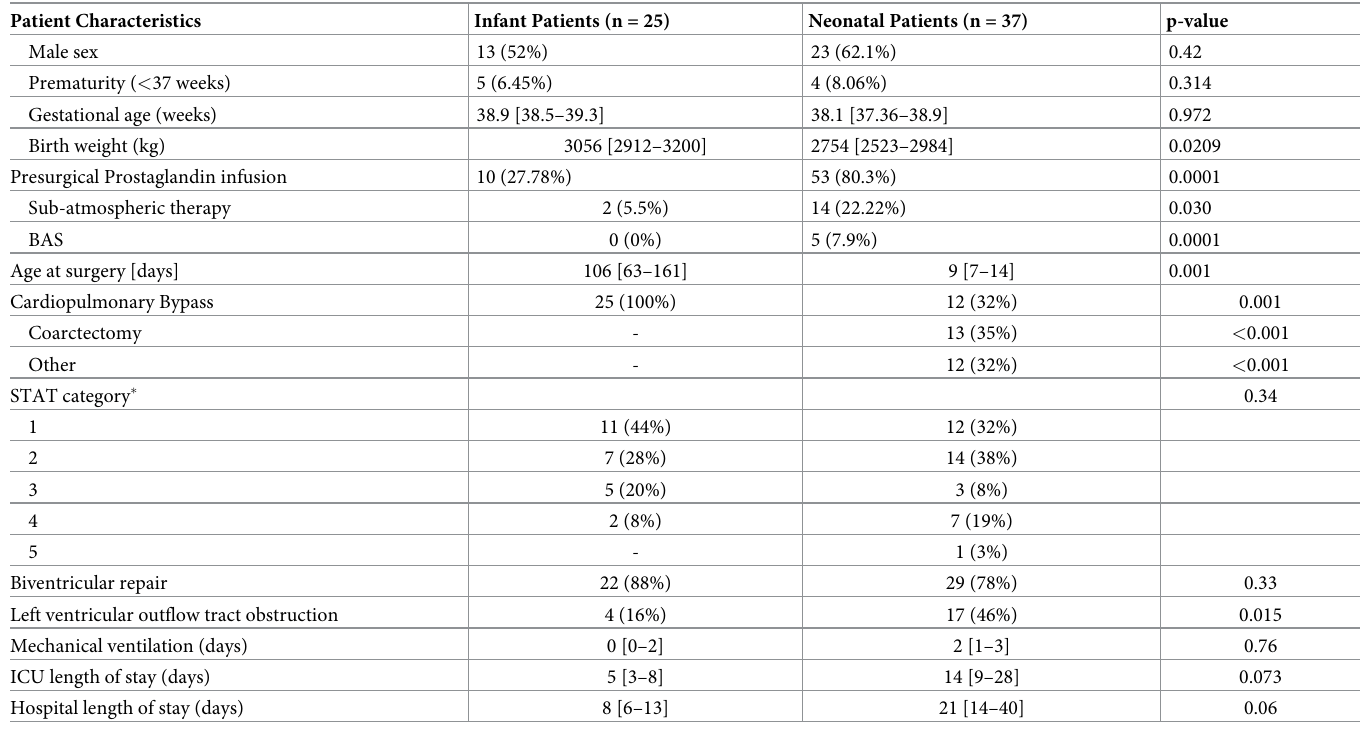
Table 1. Demographics and clinical characteristics of the study population.